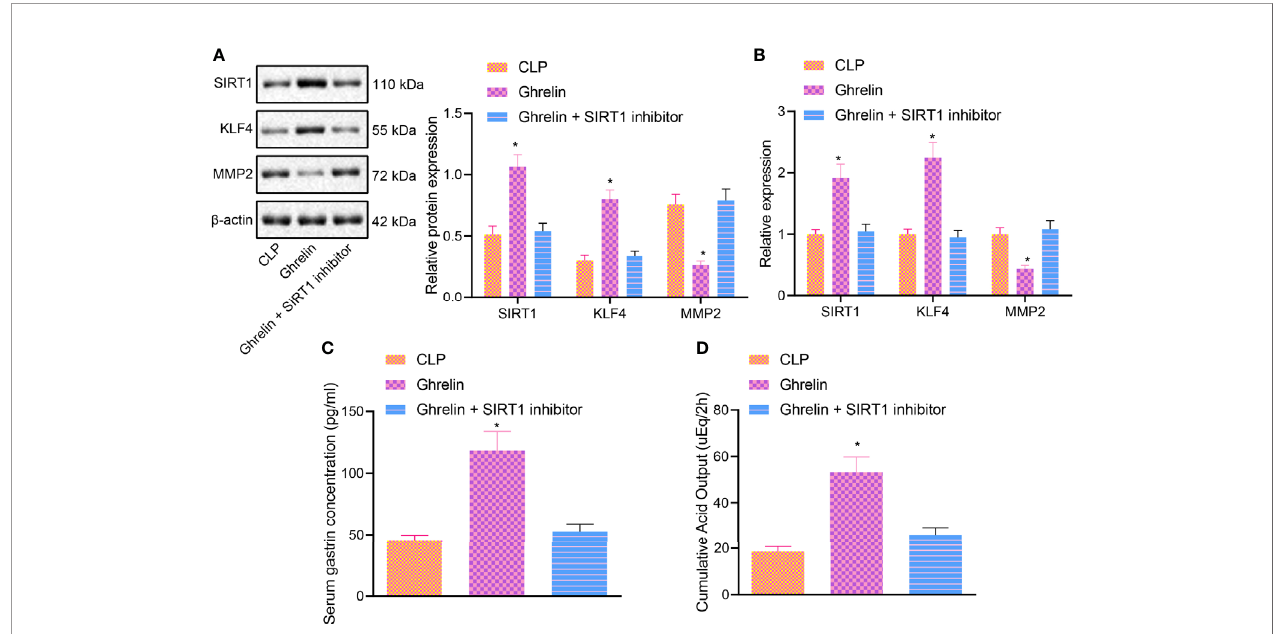
FIGURE 5 | Ghrelin regulates KLF4/MMP2 axis by activating SIRT1 and affects intestinal dysfunction in sepsis. (A) , Western blot analysis of the expression of SIRT1, KLF4 and MMP2. (B) , The expression of SIRT1, KLF4 and MMP2 determined by RT-qPCR. (C) , Gastrin secretion in each group. (D) , The accumulated gastric acid secretion. * p < 0.05 vs. CLP group. The measurement data were expressed as mean ± standard deviation. One-way ANOVA was used for the comparison among multiple groups, followed by Tukey ’ s post hoc